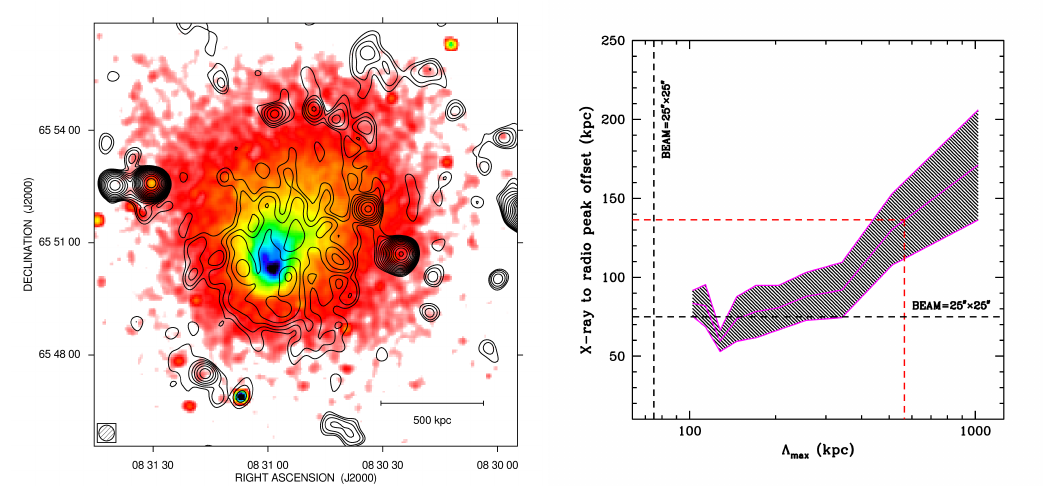
Figure 1. Left : radio image of the central region of the galaxy cluster A665. Contours show the total intensity radio emission at 1.4GHz (resolution 25 (cid:48)(cid:48) , first contour level 135 µ Jy/beam and the rest spaced √ by a factor 2), while the colors represent the X-ray emission in the 0.8–4 keV band. Right : X-ray to radio peak offset versus Λ max for synthetic radio halos. The red dashed line identifies the Λ max based on the observed X-ray to radio peak offset for the radio halo in A665. These images have been produced in the context of the work